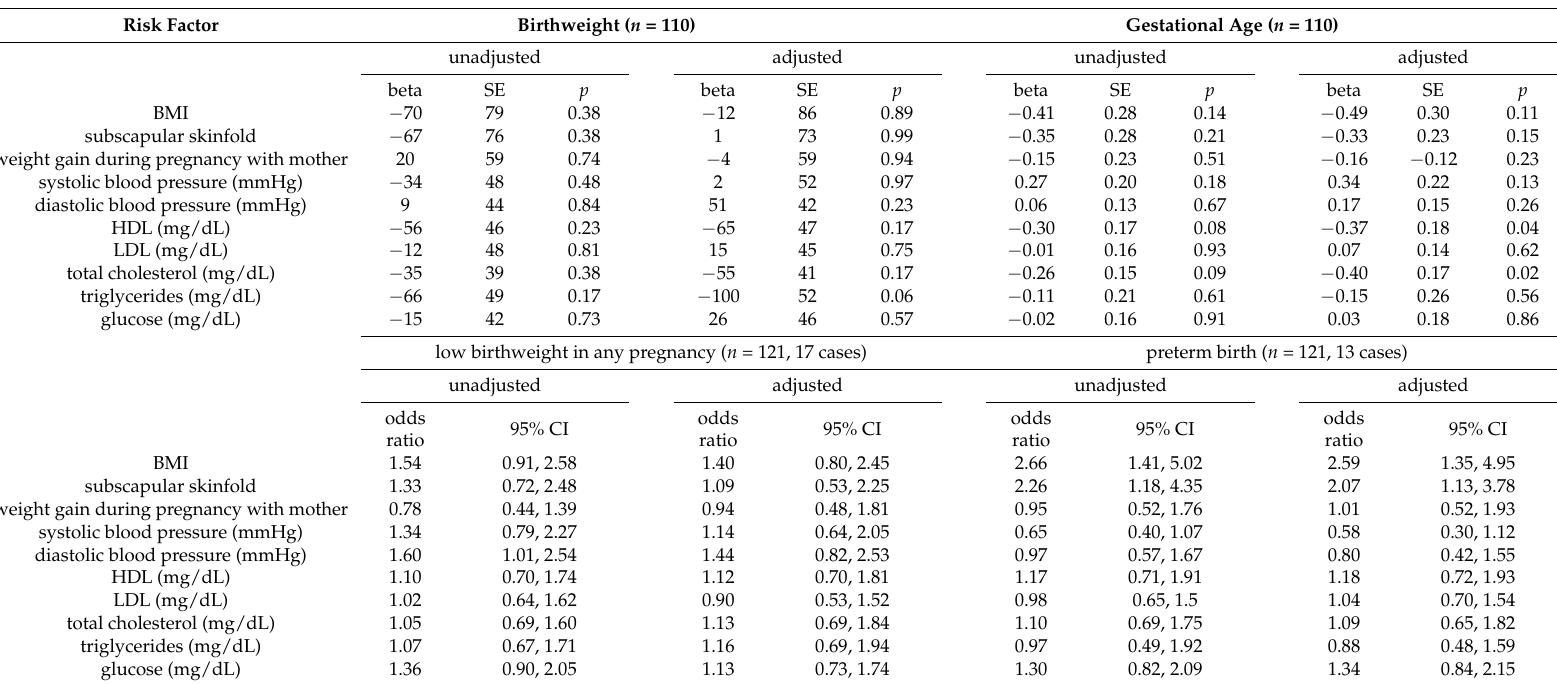
Table 4. Grandmaternal cardiovascular risk as a predictor of birth outcomes in grandchildren of female Bogalusa Heart Study participants. Risk